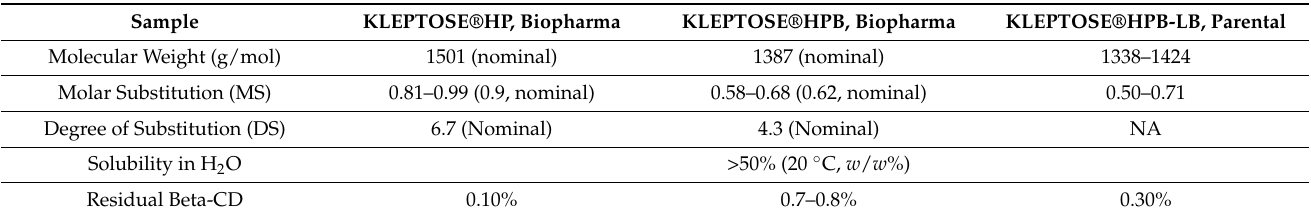
Figure 1. Chemical structure of hydroxypropyl-beta-cyclodextrin. Table 1. Key points of the KLEPTOSE® range of hydroxypropyl beta-cyclodextrins (HPβCDs).